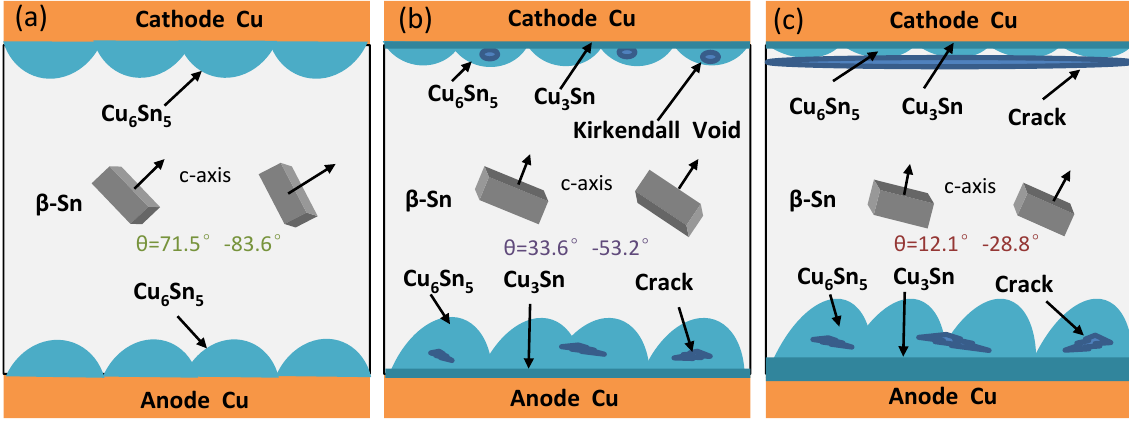
Figure 5. Schematic diagram of solder joints at different current densities for 200 h of loading: ( a ) 4 × 10 3 A/cm 2 ; ( b ) 7 × 10 3 A/cm 2 ; ( c ) 1 × 10 4 A/cm 2 .